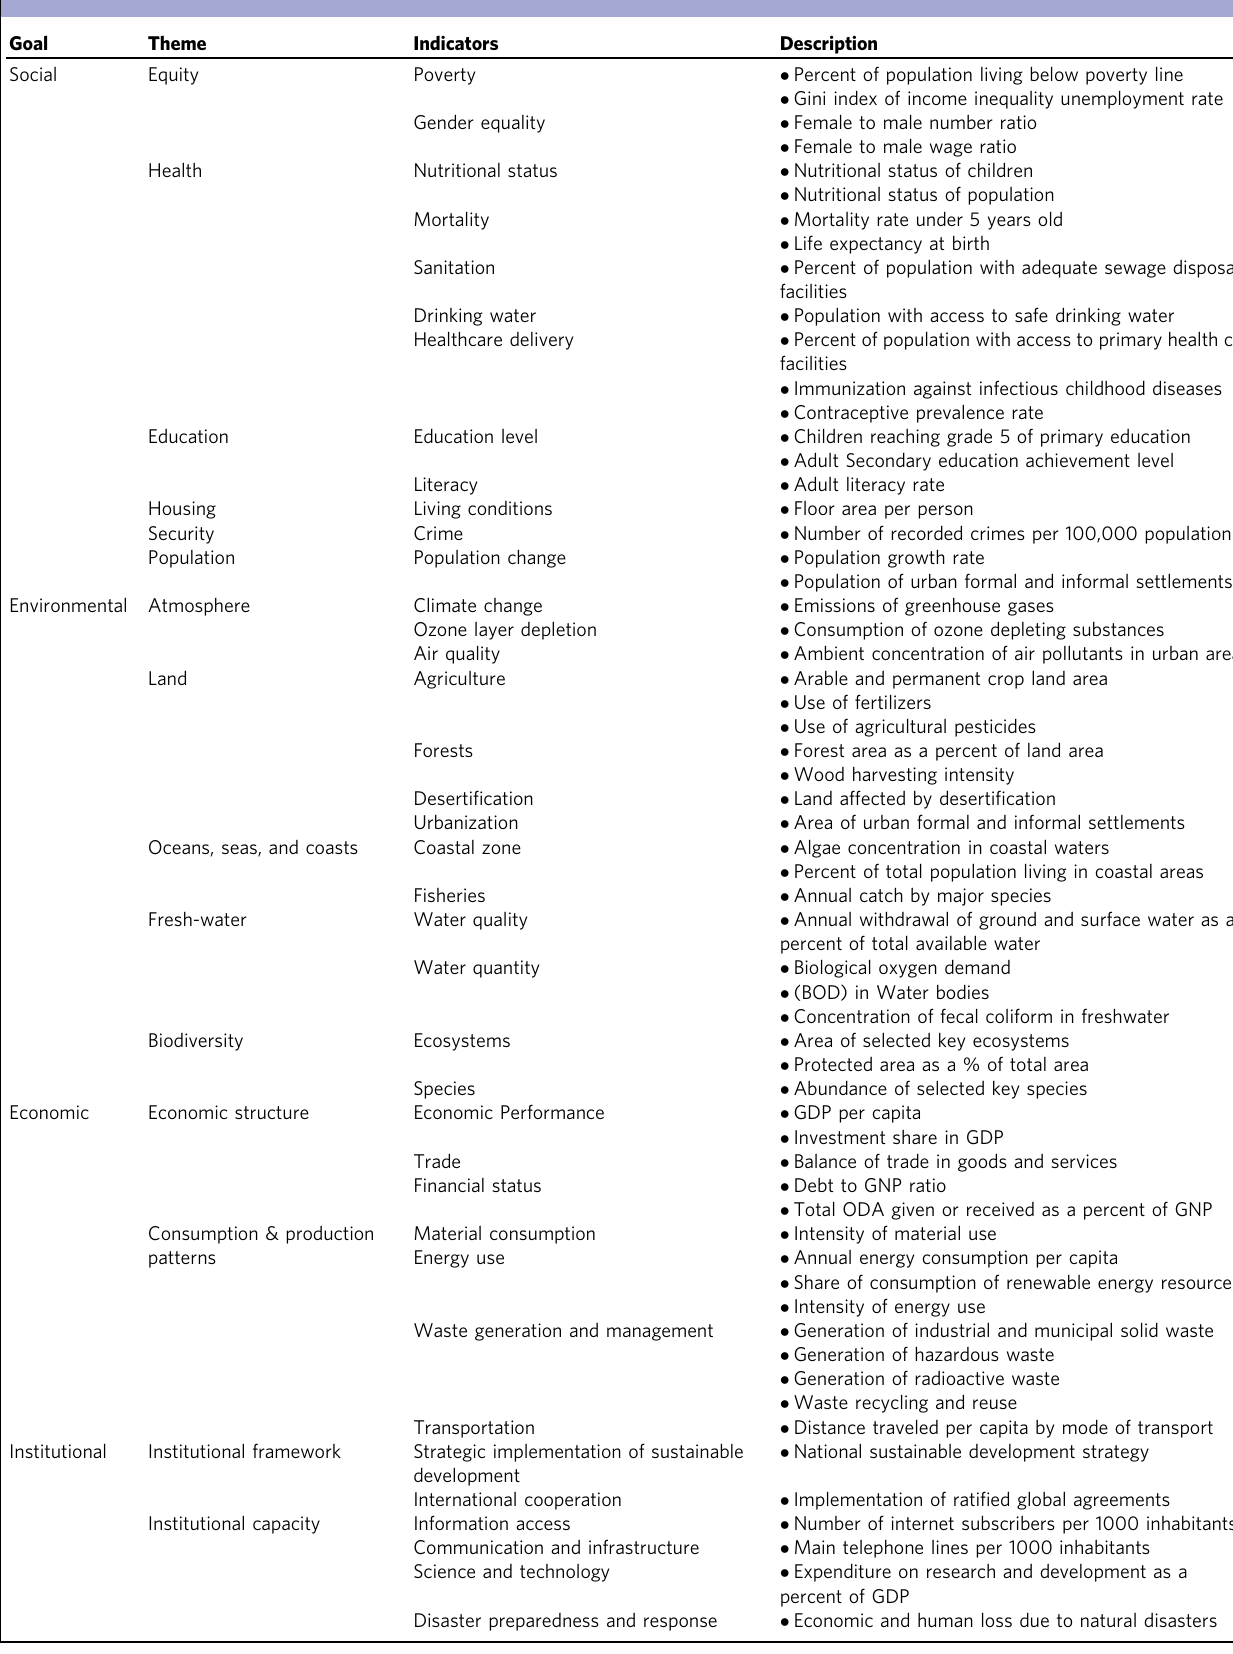
Table 2 Sustainable development indicators suggested by